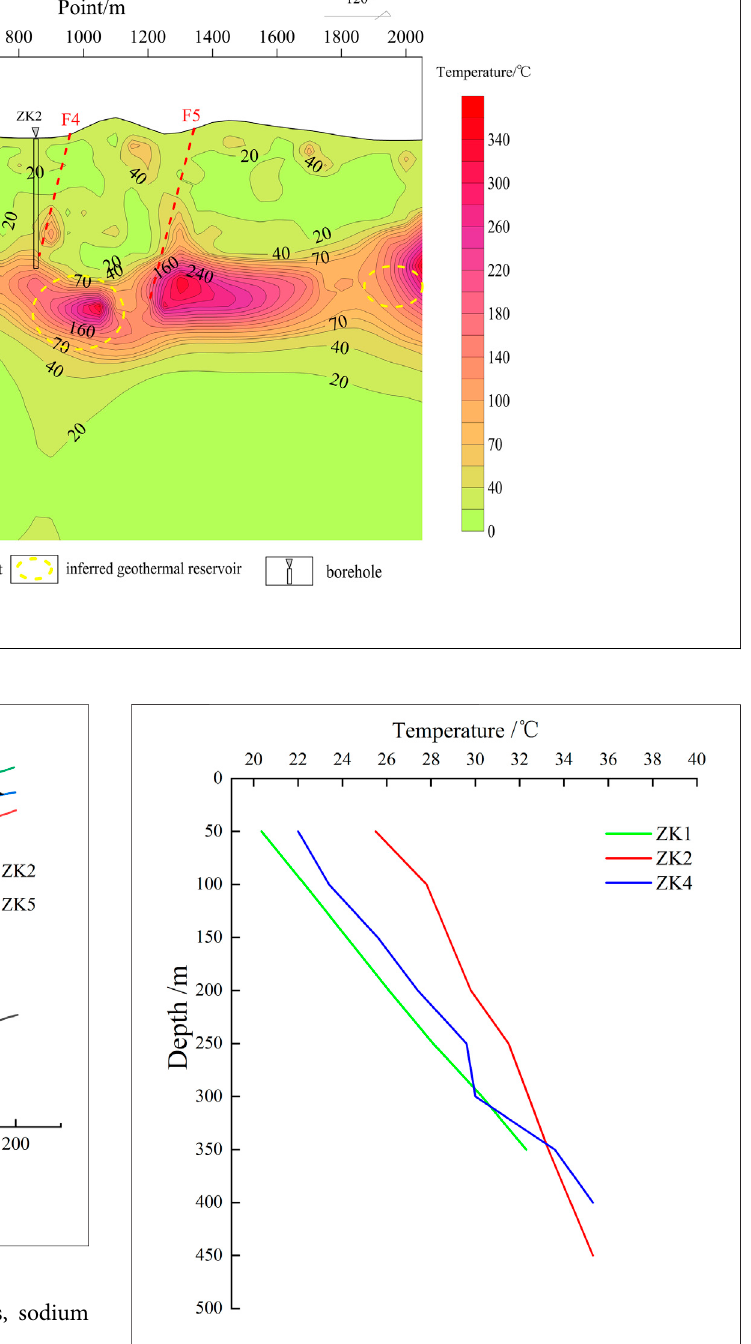
FIGURE 12 | Temperature measurement curves of wells ZK1, ZK2, and